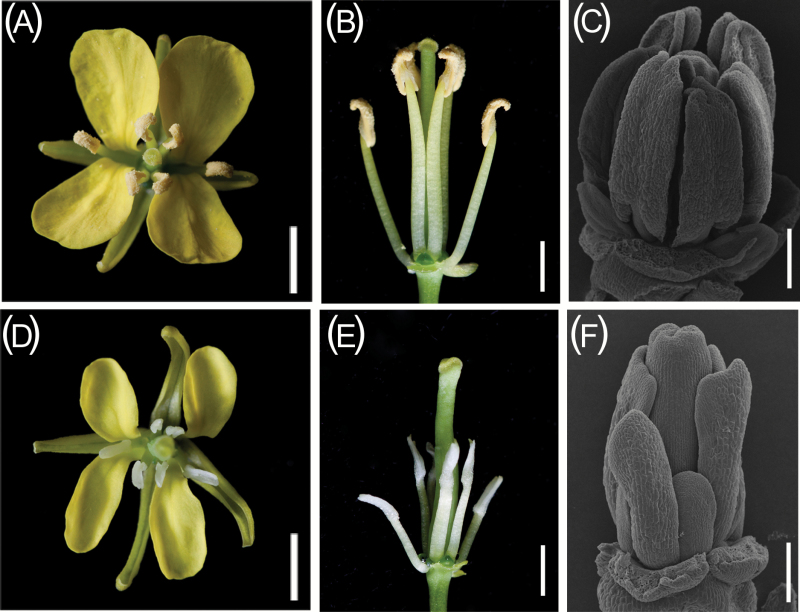
Anther phenotypes in the hau CMS lines and the maintainer line in B. juncea. (A, B) A flower from the hau CMS maintainer line (6-102B). (D, E) A flower from the hau CMS line (6-102A). Scale bars =20 mm. (C, F) A mature anther from the hau CMS maintainer line (C) and the hau CMS line (F). Scale bars =200 µm. (This figure is available in colour at JXB online.)